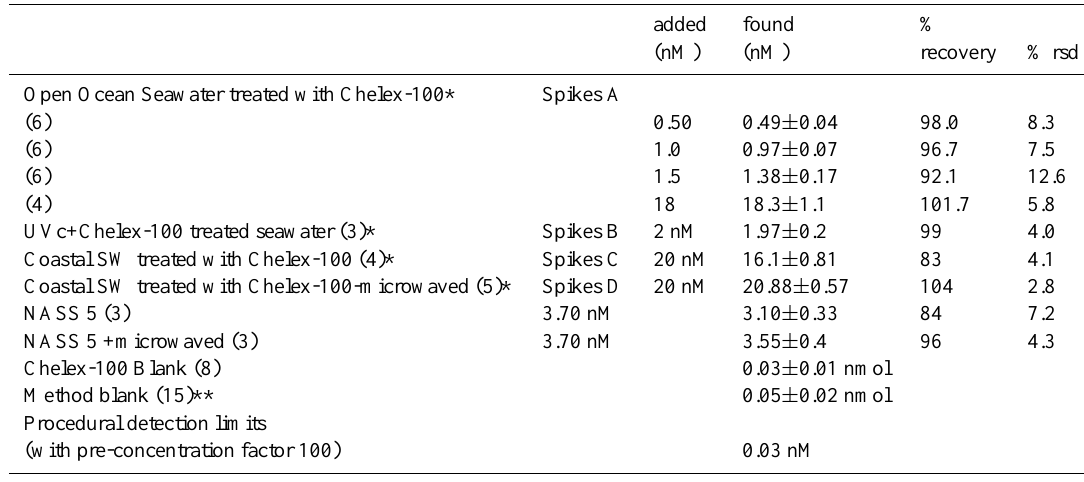
Table 1. Accuracy and precision of the method by using the certified standard materials NASS-5 (National Research Council Canada) and spiked seawater samples. Method and resin blanks with procedural detection limits have been presented in the lower section of the table. The numbers in the parentheses are the number of spikes and